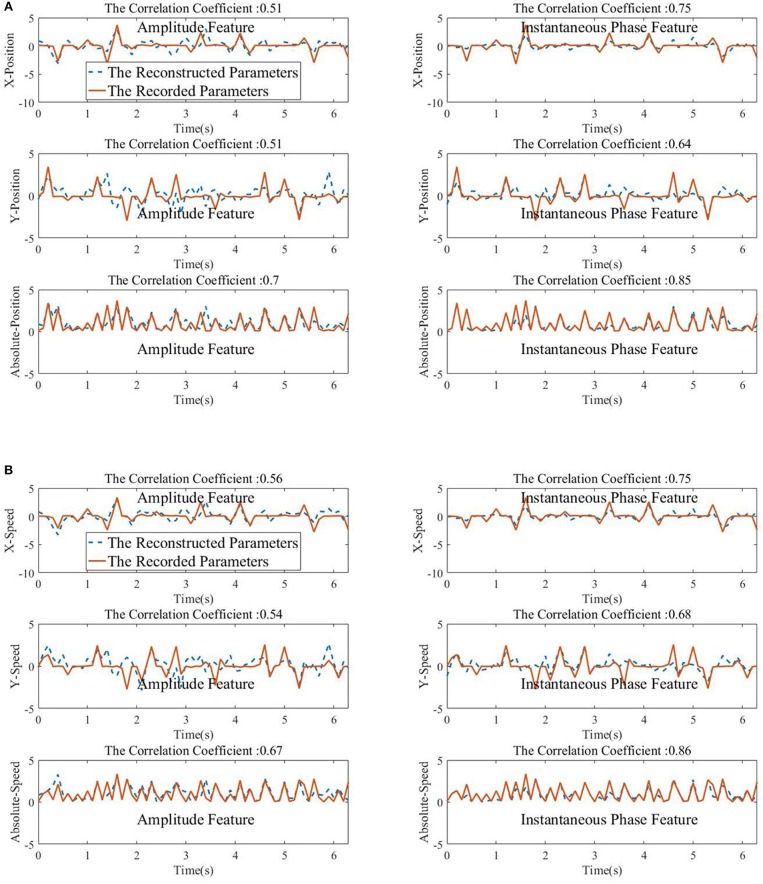
The Kalman filter reconstructed movements parameters (normalized for visualization) with the low-delta EEG amplitude feature (left column) and the phase feature (right column). The correlation coefficient between the predicted and the ground-truth parameters is given in the top of each subfigures. (A) Top panel: X-Position. Middle panel: Y-Position. Bottom panel: Absolute-Position. (B) Top panel: X-Speed. Middle panel: Y-Speed. Bottom panel: Absolute-Speed.